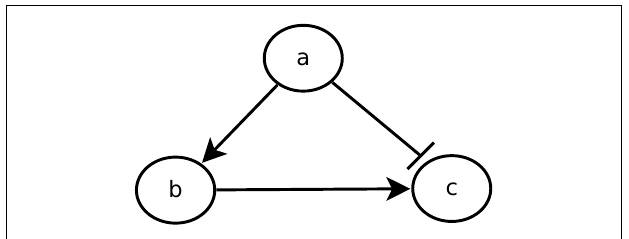
FIGURE 1 | Example of a feedforward loop